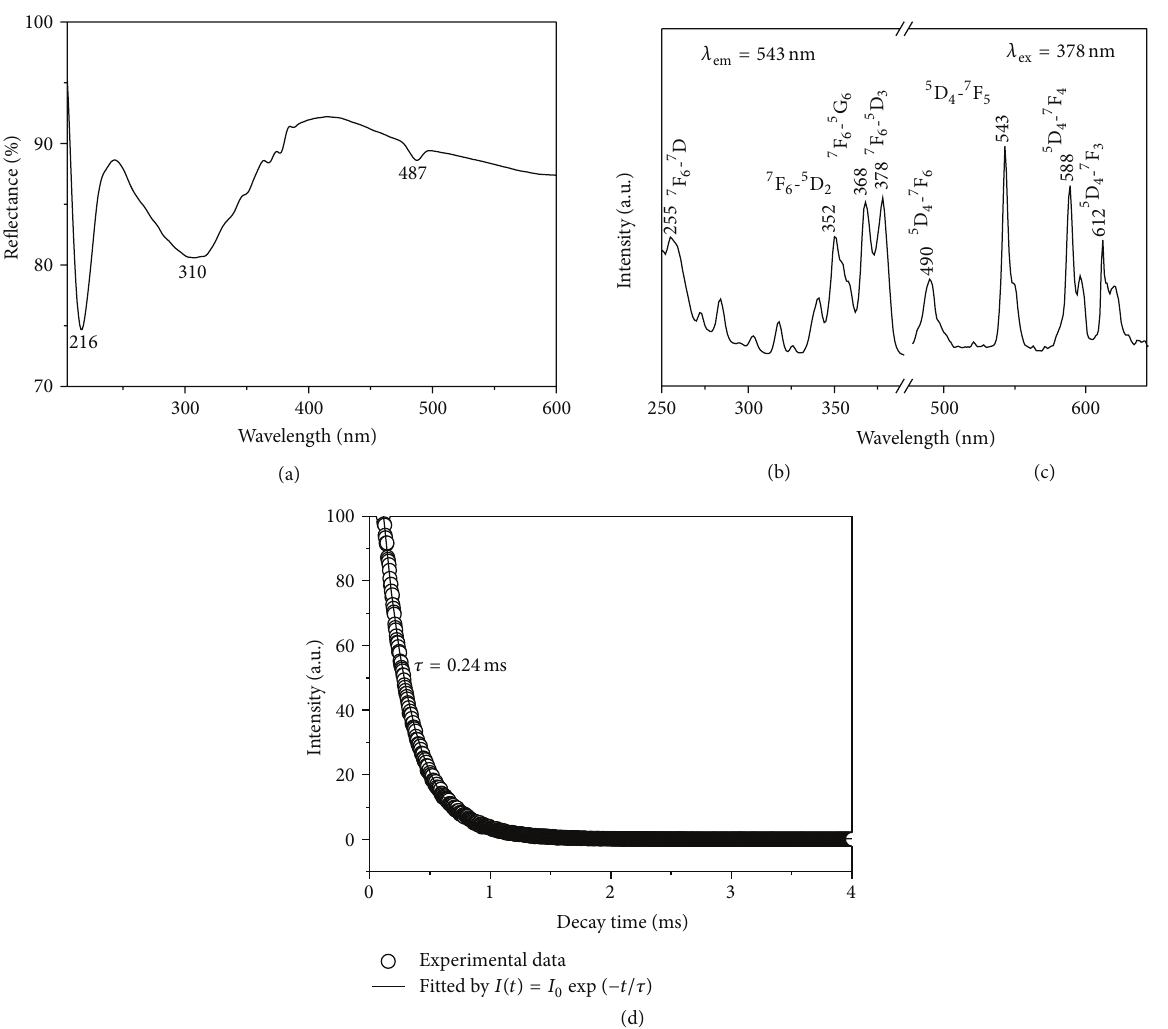
Figure 4: UV-Vis DRS (a), PL excitation (b), emission (c) spectra, and decay curve (d) of bundle-shaped TbPO 4 ⋅ H 2 O nanorods.